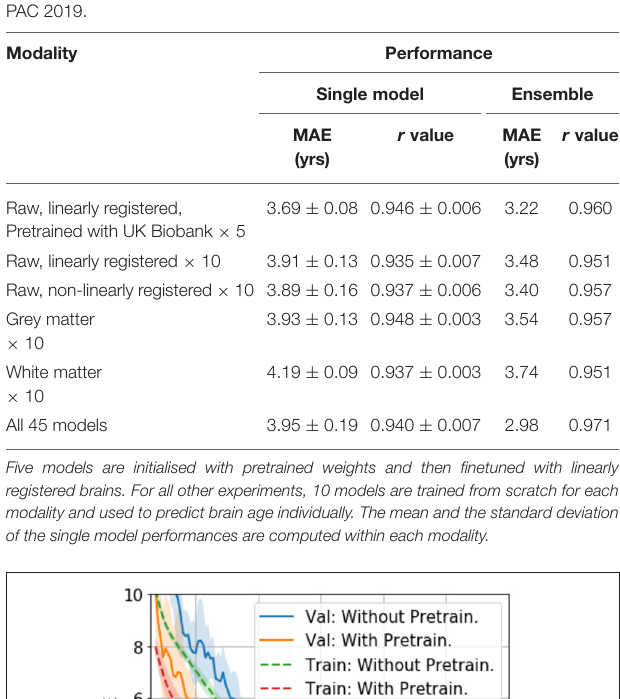
TABLE 2 | Performance of model ensembles with different pseudo modalities in PAC 2019.